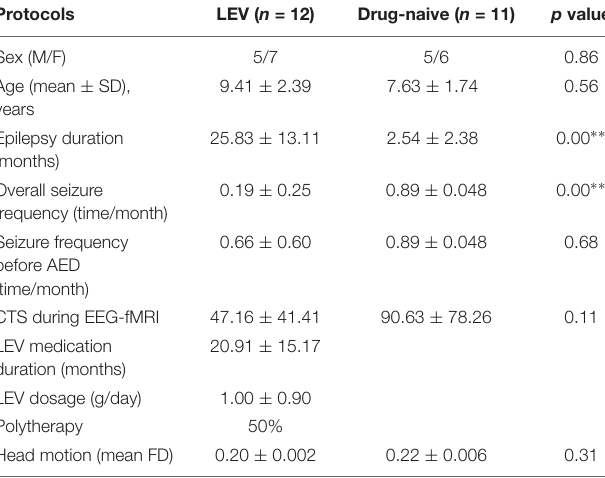
TABLE 1 | Demographics and clinical